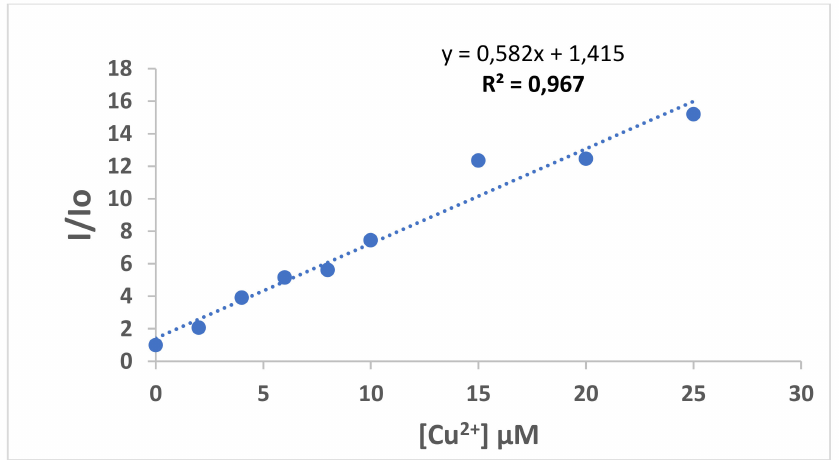
Figure 24. Stern–Volmer plot of 2-amino-4-hydroxy-6-(4-hydroxy-2-oxo-2H-chromen-3-yl)nicotinonitrile 4 with increasing concentrations of Cu 2+